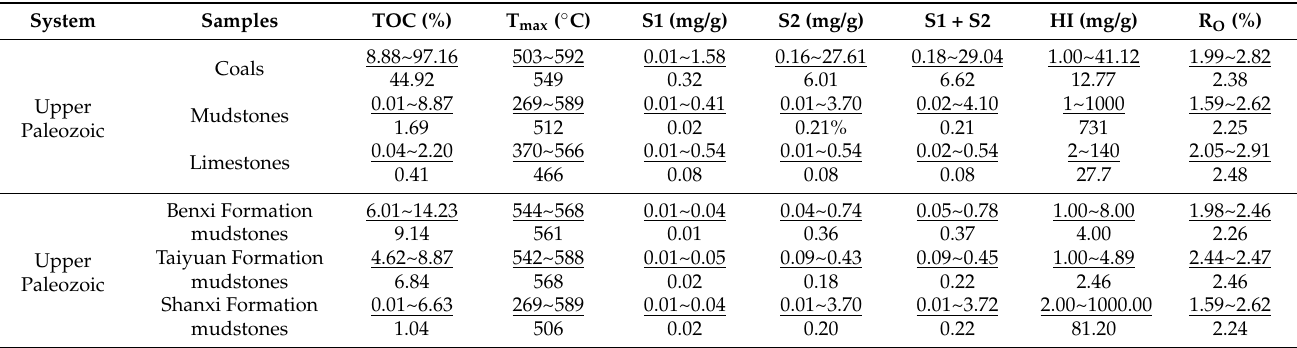
Table 1. Rock-Eval pyrolysis data of the source rock